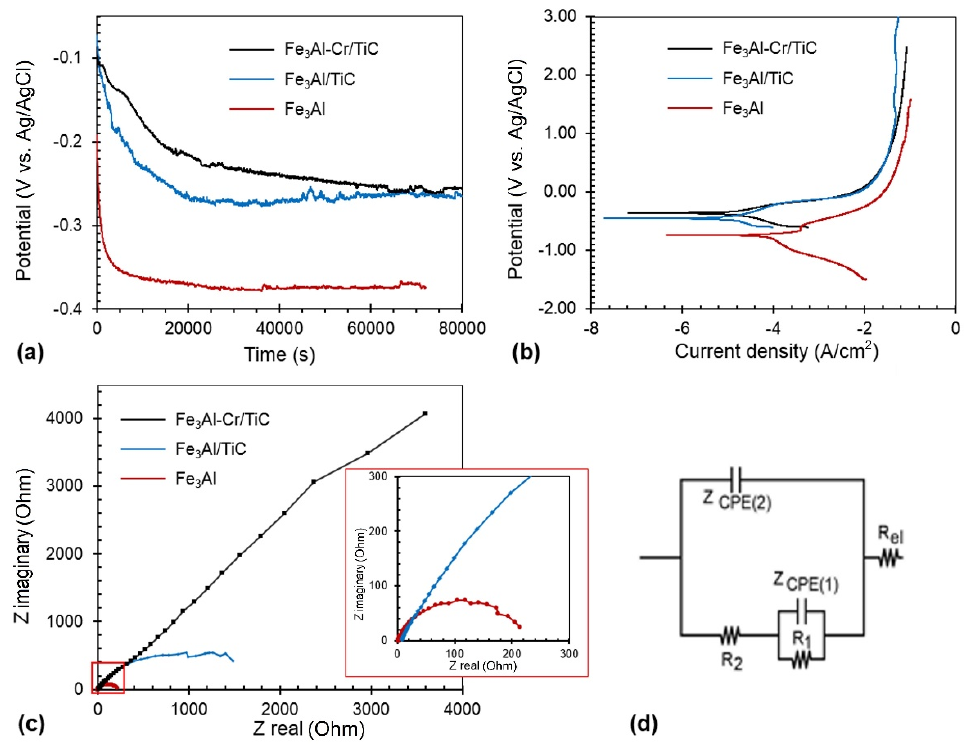
Figure 1. Electrochemical test results of Fe 3 Al, Fe 3 Al / TiC and Fe 3 Al-Cr / TiC in freely aerated 3.5 wt. % NaCl solution: ( a ) open circuit potential measured for up to 20 h, ( b ) potentiodynamic polarization curves, ( c ) Nyquist plots, and ( d ) proposed equivalent circuit model.